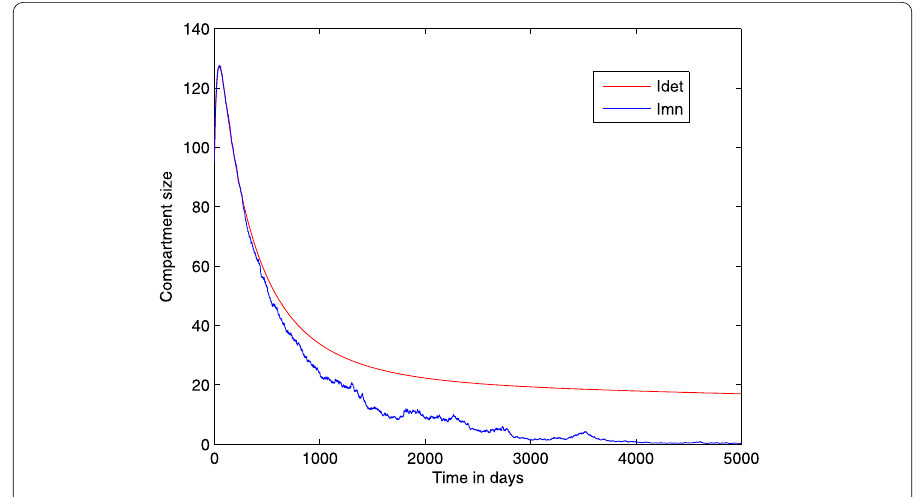
Figure 3 The mean of the (stochastic) I -paths over 8000 runs, compared with the deterministic I -path [ σ = 0.0002, ζ = 0.05]. The graph illustrates the stability theorem, Theorem 4.3: Although R 0 = 1.0202 > 1 means that the deterministic model yields the instability of the disease-free equilibrium and stochastic perturbations cause the convergence (almost surely) to disease-free